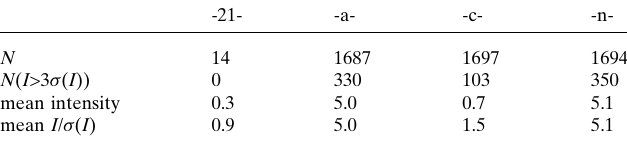
Table 4 Systematic absence exceptions for (II) (space group P 2 1 / c